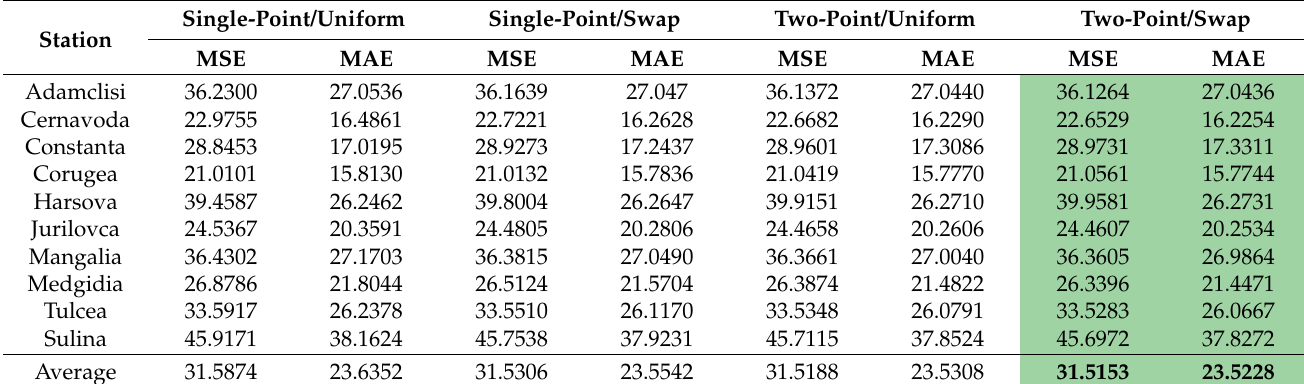
Table 6. MSEs and MAEs in GA. The best results are highlighted.